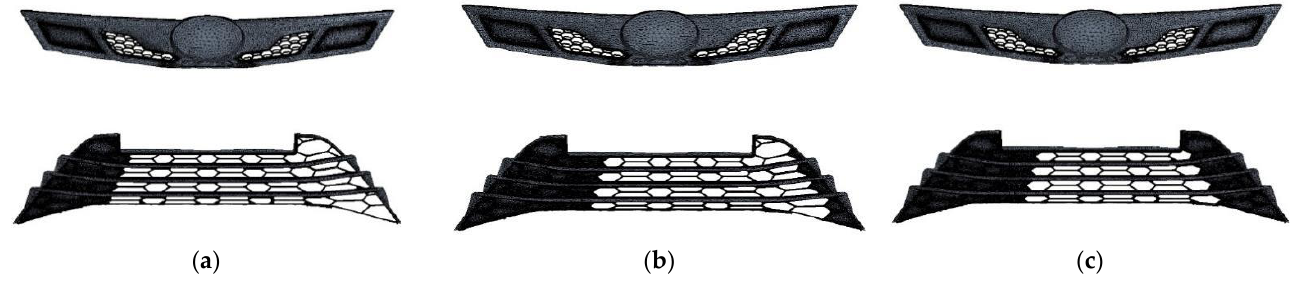
Figure 20. Closure schemes of lower grille: ( a ) scheme 1; ( b ) scheme 2; ( c ) scheme 3.